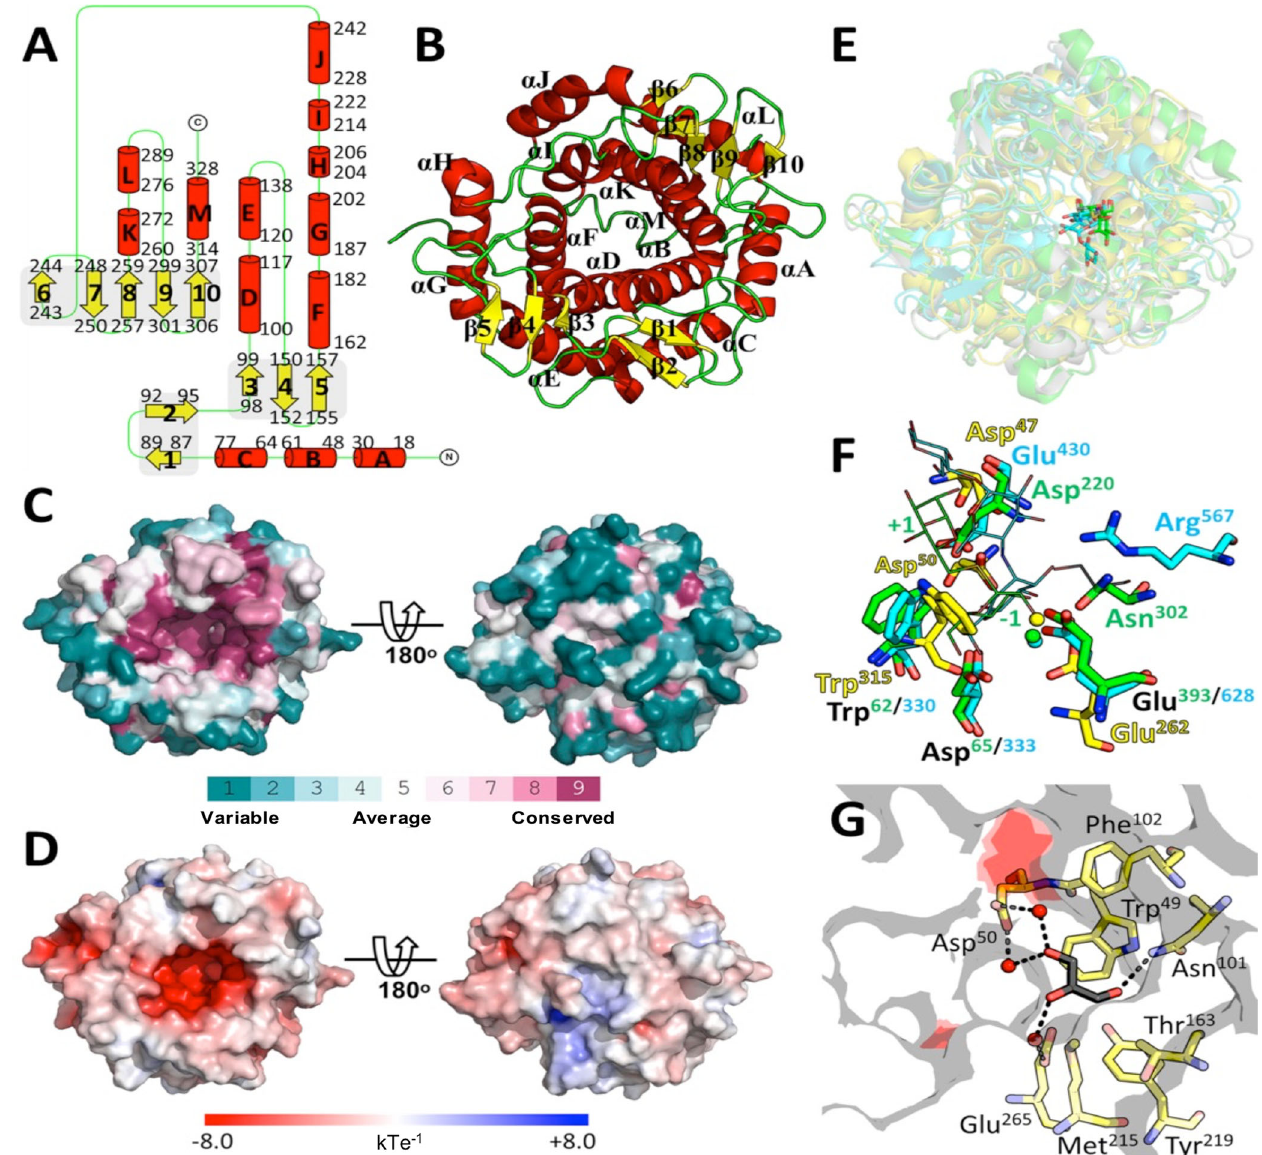
Fig. 3 Overall structure of M. hassiacum MmpH and structural comparison. A Topology diagram of MmpH with α -helices (A – M) and β -strands (1 – 10) represented as red cylinders and yellow arrows, respectively. The number of the fi rst and last residue of each secondary structure element is indicated. B Cartoon representation of the MmpH monomer with secondary structure elements colored as in panel ( A ). C Solid surface representation of MmpH colored according to ConSurf 83 residue conservation score, calculated from the amino acid sequence alignment of 150 MmpH homologues ( fi g. S7). The color-code gradient (from teal for variable positions to purple for highly conserved ones) is shown at the bottom of the panel. The left pose is oriented as in panel B (top view). The right pose results from a 180° rotation of the left pose around x (bottom view). D Solid surface representation of MmpH colored according to its electrostatic surface potential (calculated with APBS 84 , as implemented in PyMOL (Schrödinger)), contoured from − 8 (red) to 8 kT/e (blue). The two views of the MmpH monomer are those depicted in panel ( C ). E Superposition of MmpH (yellow) in the same orientation as in panel B with GH15 family member-G1d from Arthrobacter globiformis (cyan; PDB entry 1ULV 28 ), CpGH125 from Clostridium perfringens (green; PDB entry 3QT9 29 ) and SpGH125 from Streptococcus pneumoniae (grey; PDB entry 3QRY 29 ). All proteins are shown in cartoon representation and the ligands acarbose, α -1,6-linked 1-thio- α -mannobiose and 1-deoxymannojirimycin (dMNJ) as stick models with carbon atoms colored as the corresponding cartoon, nitrogen atoms blue, oxygen red and sulfur yellow. F Close-up view of the superposed (-1) sugar binding subsites of G1d, CpGH125 and MmpH. Most residues involved in sugar recognition, as well as the catalytic acid and base are shown as stick models (color code as in panel E ). Water molecules important for the inverting reaction mechanism are shown as spheres and colored as the carbon atoms of the corresponding protein. Sugar-binding subsites ( − 1) and ( + 1) of α -1,6-linked 1-thio- α -mannobiose-binding CpGH125 are indicated for clarity. G Close-up of the adjacent subsite of MmpH, represented as a transparent grey surface with the putative catalytic acid (Asp47) and base (Glu262) colored red. Residues establishing contacts with the bound glycerol molecule are represented as stick models and colored as in panel ( F ). Dashed black lines and red spheres represent hydrogen bonds and water molecules,